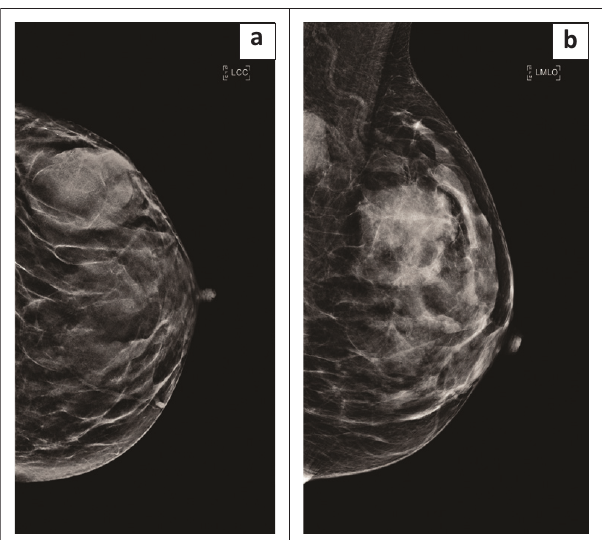
the left breast demonstrating a round mass lesion in the upper outer quadrant and a pathological node in the axilla.